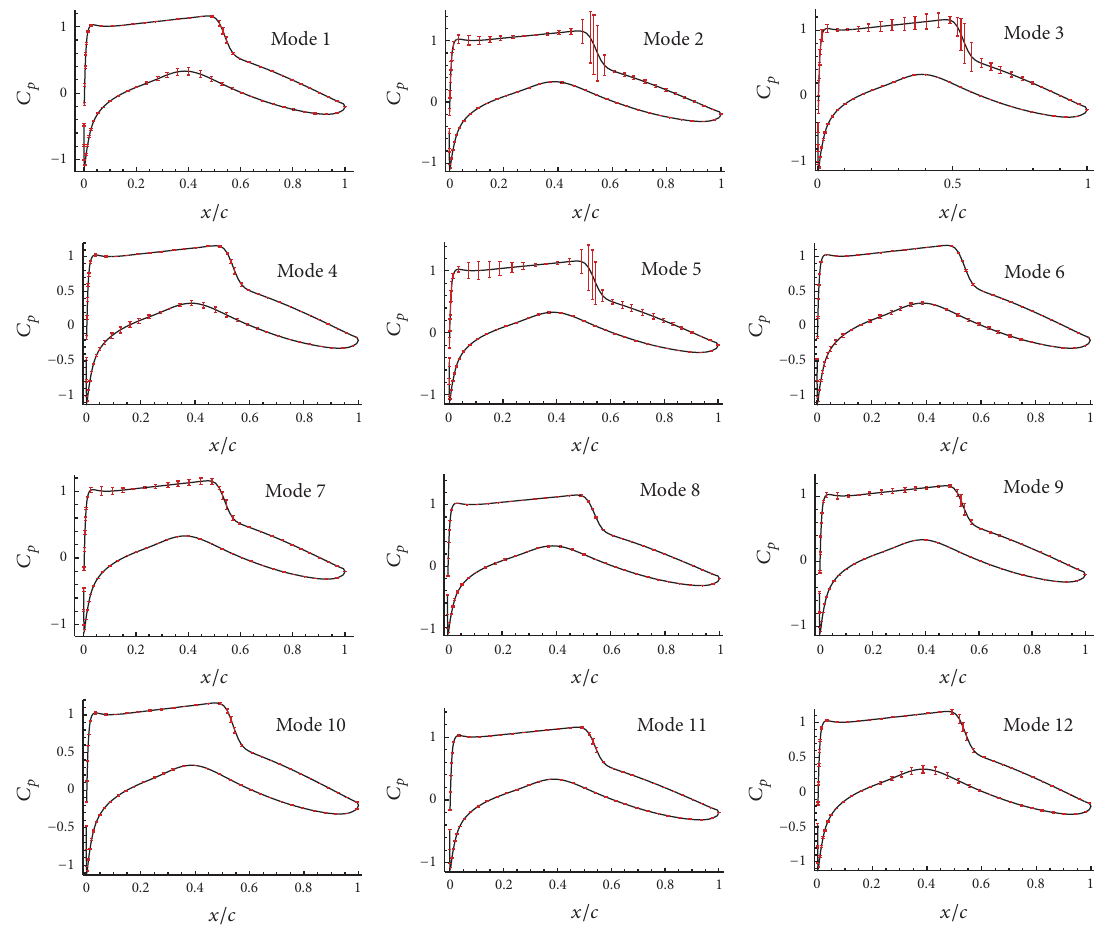
Figure 14: The error bars of 𝐶 𝑝 distribution by Sobol’s